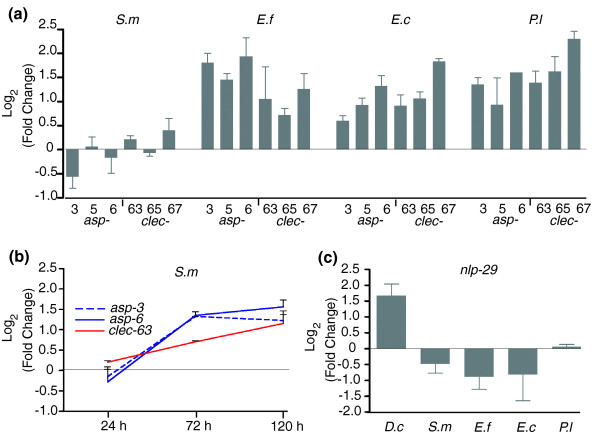
qRT-PCR analyses. (a) Expression levels of common response genes representing two gene families were measured and data reported as mean difference between infected and control animals following infection with the four pathogens (S. m, S. marcescens; E. f, E. faecalis; E. c, E. carotovora; P. l, P. luminescens). (b) The expression levels of asp-3, asp-6 and clec-63 were followed over a period of five days in C. elegans infected with S. marcescens; data reported as mean difference between infected and control animals. Bars represent standard errors (at least two independent measurements). (c) The antimicrobial gene nlp-29 responds specifically to fungal infection. The expression levels of nlp-29 were measured following infection with the fungal pathogen (D. c, D. coniospora) and the four bacterial pathogens. Data are reported as mean difference between infected and control animals. Bars represent standard errors (three independent measurements).